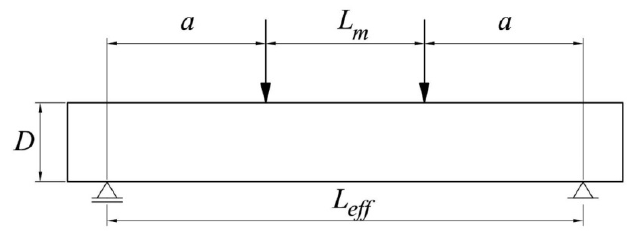
Figure 3. Geometry of analyzed beams.